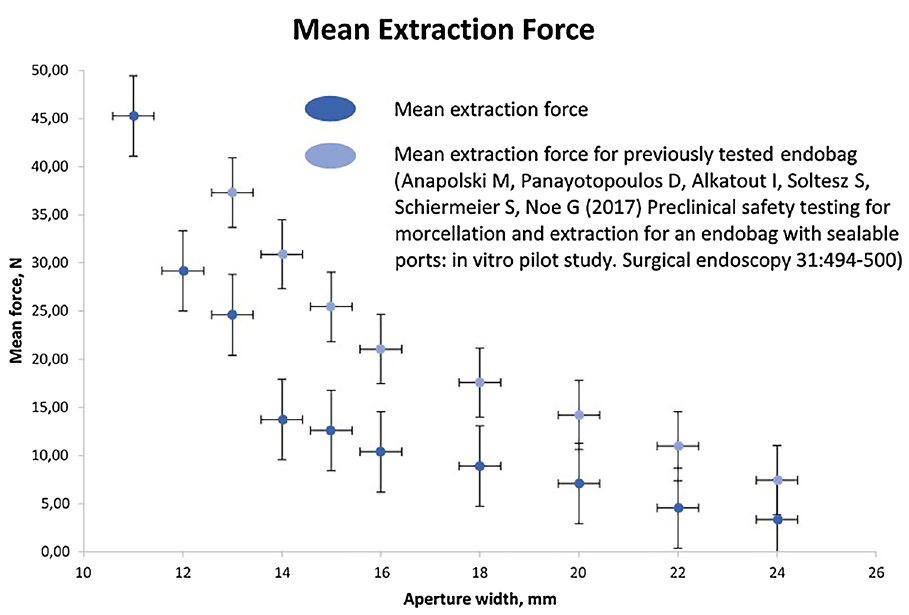
Figure 5. Force needed to extract the bag compared to a predecessor